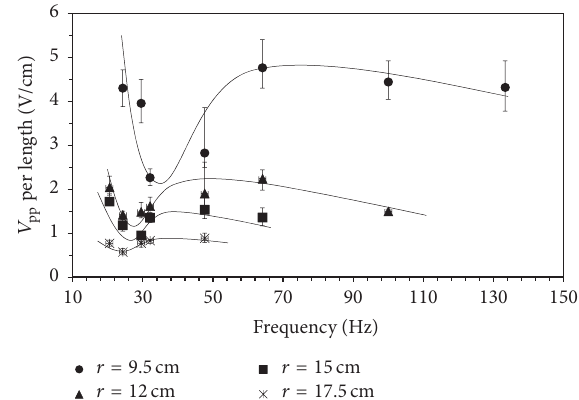
Figure 7: Voltage output per length of the PZT cantilever plotted against oscillation frequency for different radii of curvature. Right shift of the frequency response curve at higher bending amounts is obvious. Solid lines are drawn for eye